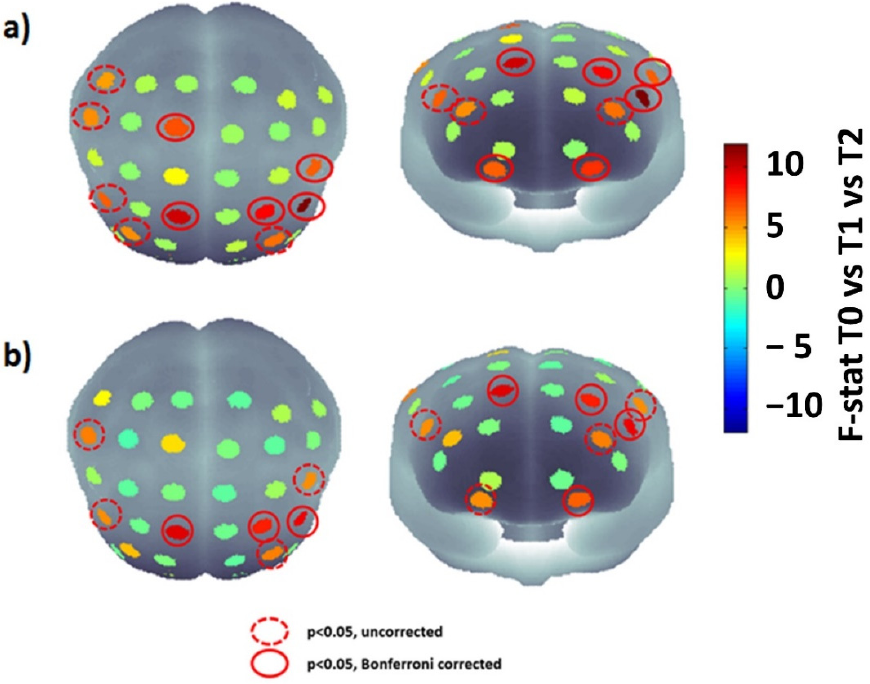
Figure 4. Comparative statistical maps (F-statistic) of cortical activation for HbO ( a ) and HHb ( b ) at T0, T1, and T2 showing the RM-ANOVA results. Significant channels ( p < 0.05) that do not get through Bonferroni correction are represented by red circles with dashes, whereas continuous red circles represent channels that remain significant ( p < 0.05) after the multiple comparison correction.